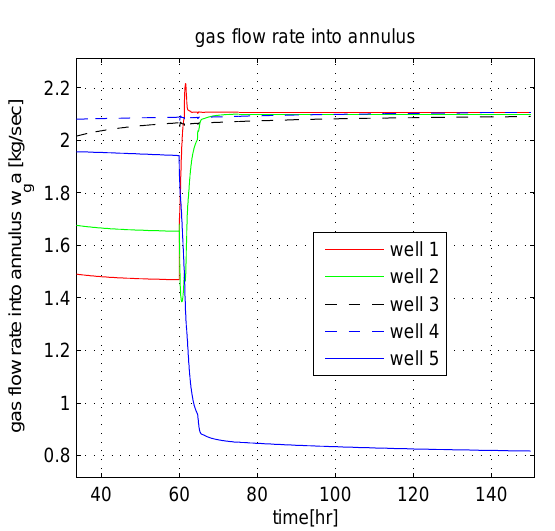
Figure 13: Gas distribution among wells using hill climbing optimizer turned ’ON’ at t = 60 hours